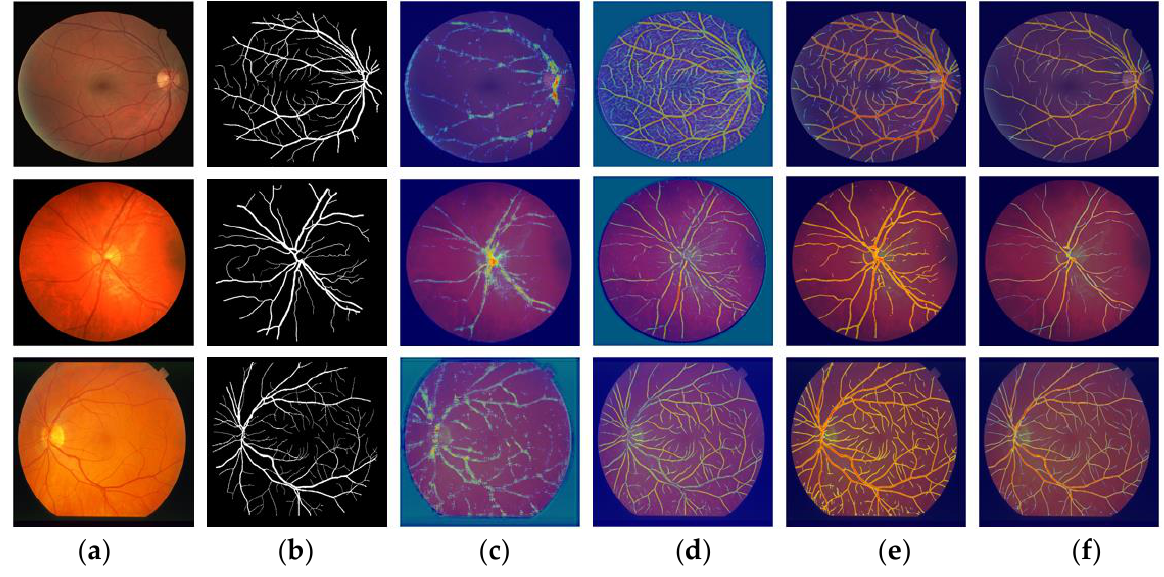
20 of 25 Figure 10. VSUL-Net output mask analysis for misses, discontinuities, and over-segmentation: ( a ) original fundus image, ( b ) expert annotation, ( c ) VSUL-Net predicted mask, and ( d ) mask-annota- tion overlapping image (TP is presented in blue, FN in red, and FP in green). The prediction obtained from the network is based on specific features, which are important for the development of a robust segmentation network. The deep learning net- work behaves like a black box, without explaining the discriminative features that con- tribute to predicting a specific pixel label. Gradient-weighted class activation map (Grad- cam) [83] is a method for visualizing discriminative features that contribute to detecting